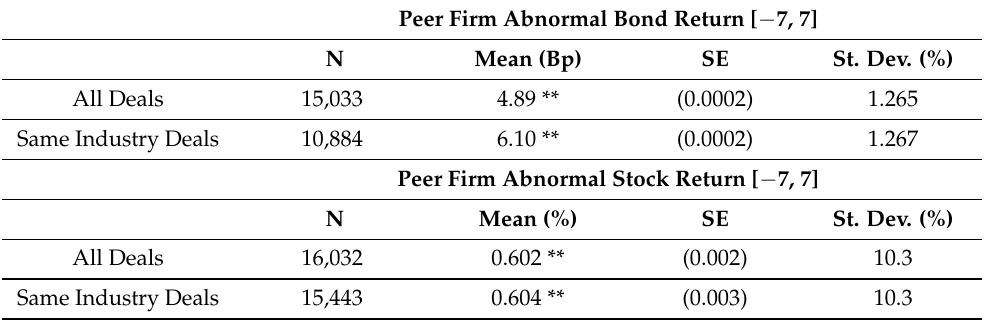
Table 3. Peer Firms’ Stakeholder